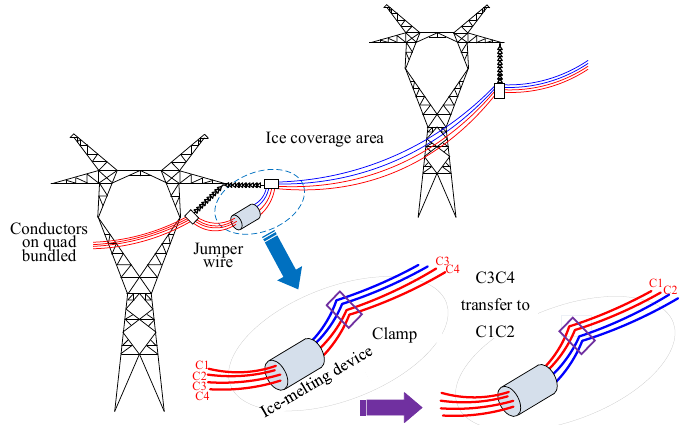
Figure 18. Working mode diagram of current transferred ice melting device.